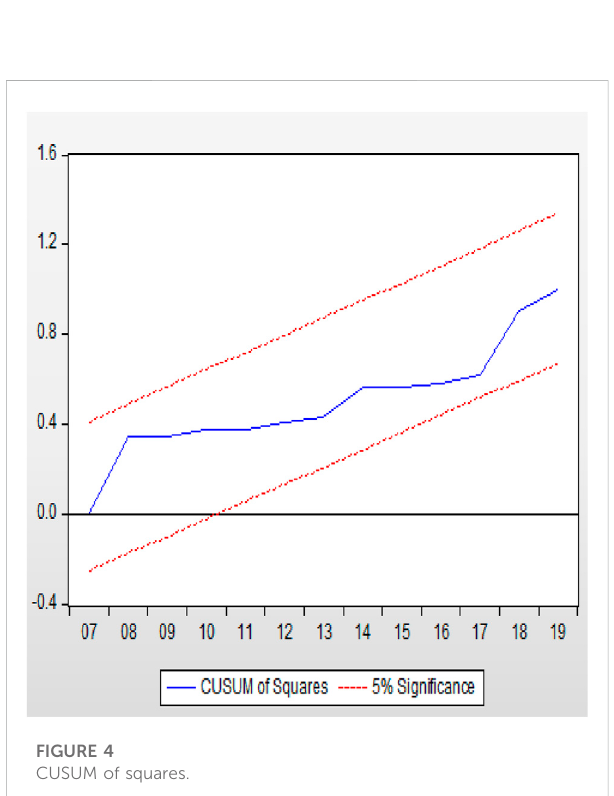
FIGURE 4 CUSUM of squares.